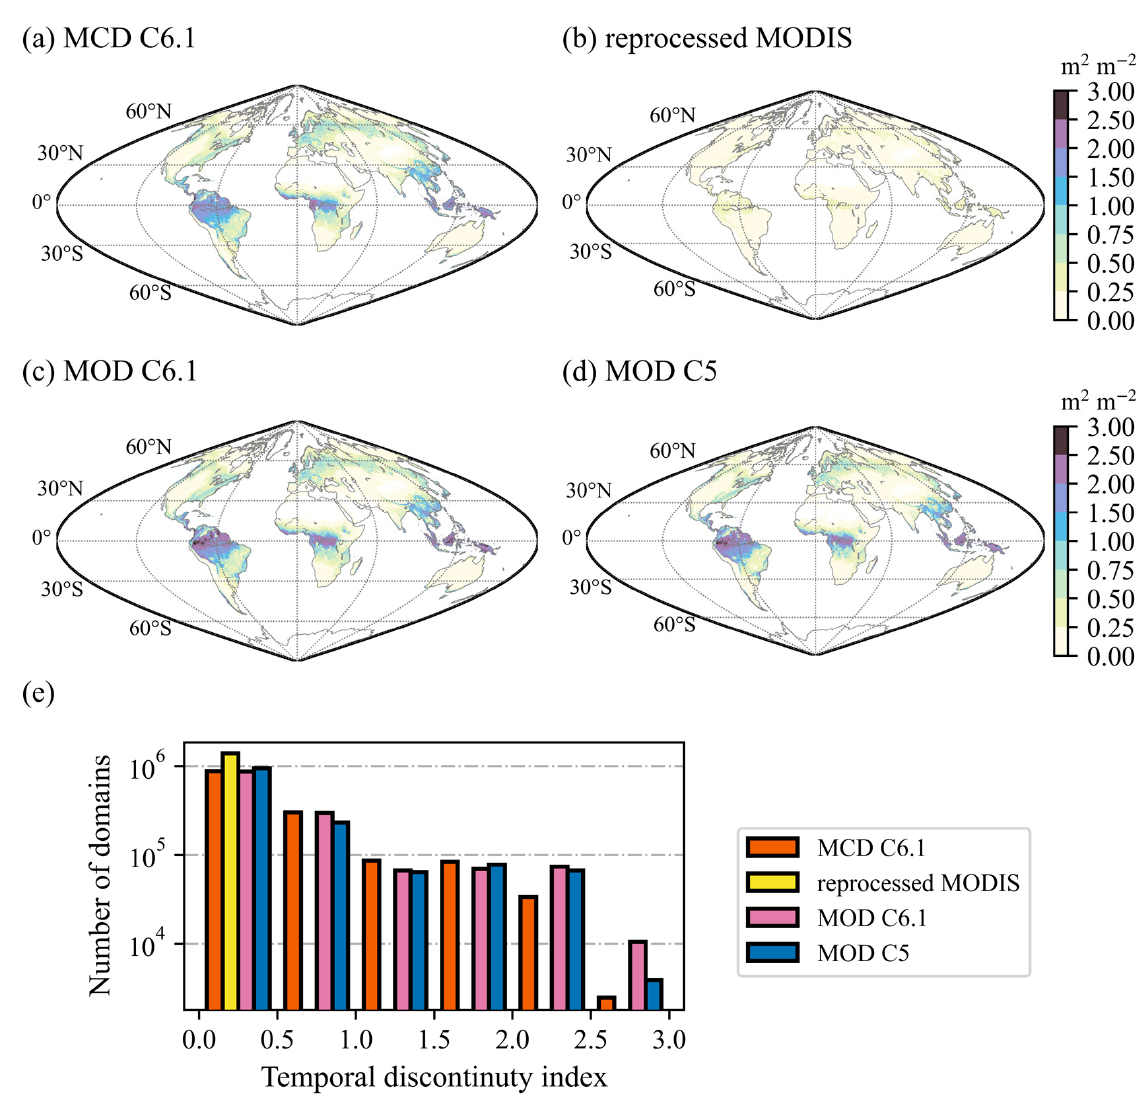
Figure 6. Temporal discontinuity index (TDI) maps of ( a ) MCD15A2H C6.1, ( b ) reprocessed MODIS, ( c ) MOD15A2H C6.1, and ( d ) MOD15A2H C5 LAI products for the 14-year (2013–2016) period, and ( e ) the numbers of domains in TDI maps over different